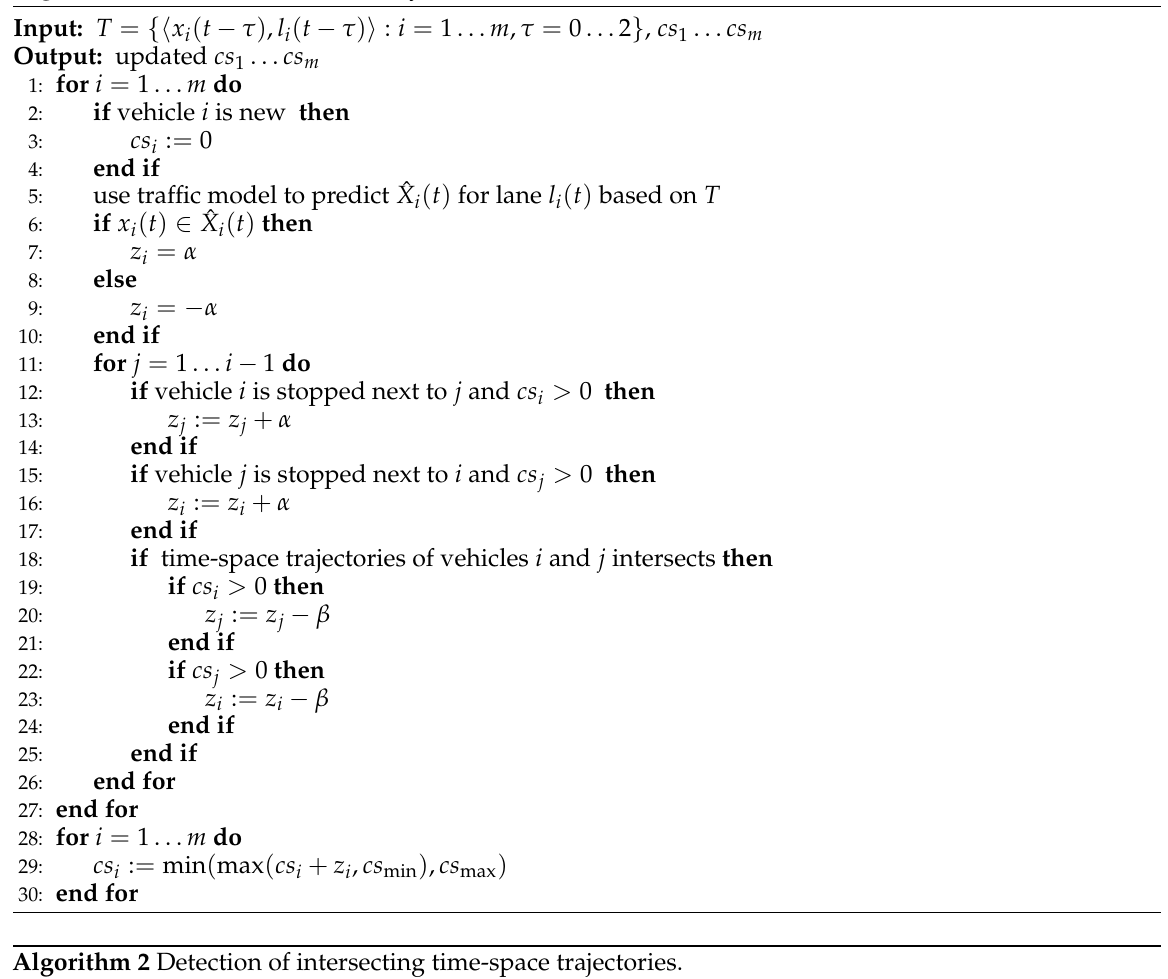
Algorithm 1 Evaluation of credibility scores